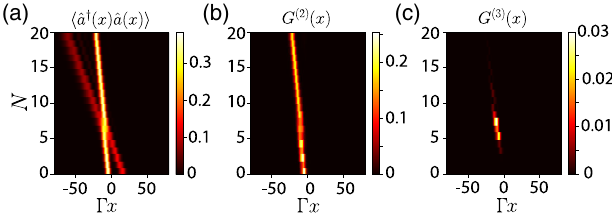
FIG. 4. Evolution of the state j in i (see text) demonstrating the interaction between a two-photon bound state centered at a 2 ¼ − 10 = Γ and a single photon centered at a 1 ¼ 15 = Γ both ffiffiffi p 2 with width σ Γ ¼ 3 . The output observables (a) h ˆ a † ð x Þ ˆ a ð x Þi , (b) G ð 2 Þ ð x Þ , and (c) G ð 3 Þ ð x Þ are plotted versus the number of emitters N